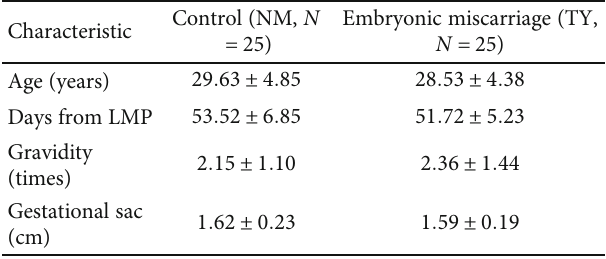
Table 1: Characteristics of study participants and control.